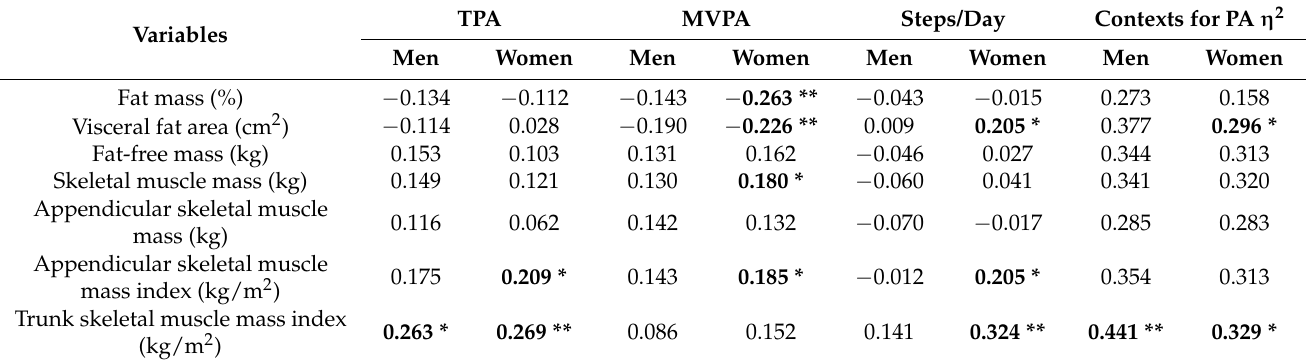
Table 4. Correlations of PA with body composition in both genders.